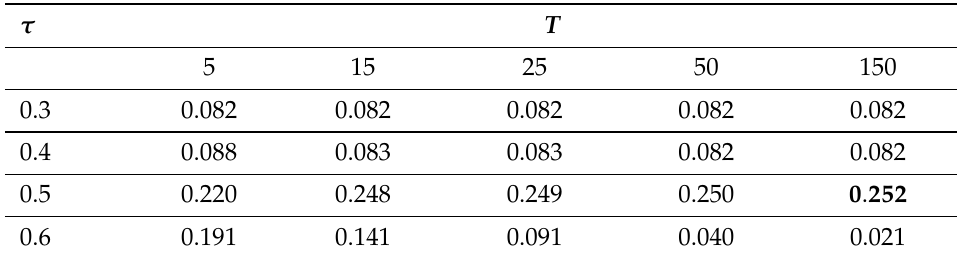
Table 5. F1-scores of the original iForest as a function of the number of trees T and the hyperparameter τ for the Normal dataset.